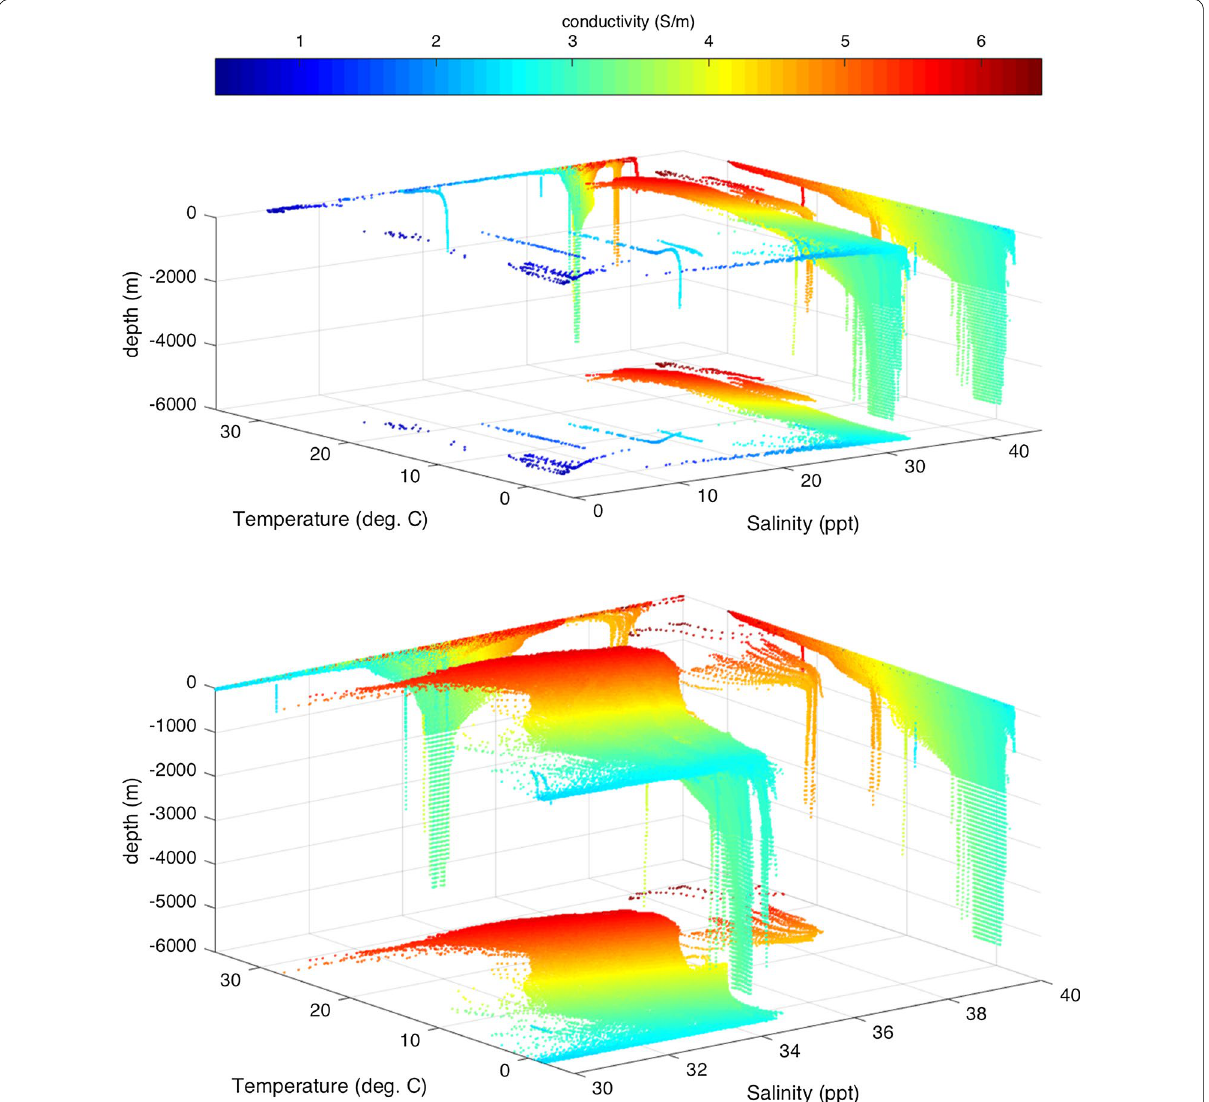
Fig. 4 Scatter plot showing data set of global ocean conductivity (values given by color scale) as distributed in coordinates of co-located salinity, temperature, and depth. Planar projections are also included. Clusters describe distinct water mass properties from various ocean bodies. The bottom panel is a magnification of the top panel, excluding the atypical low-salinity clusters associated with inland seas (see text). Most of the vari- ability is near the ocean